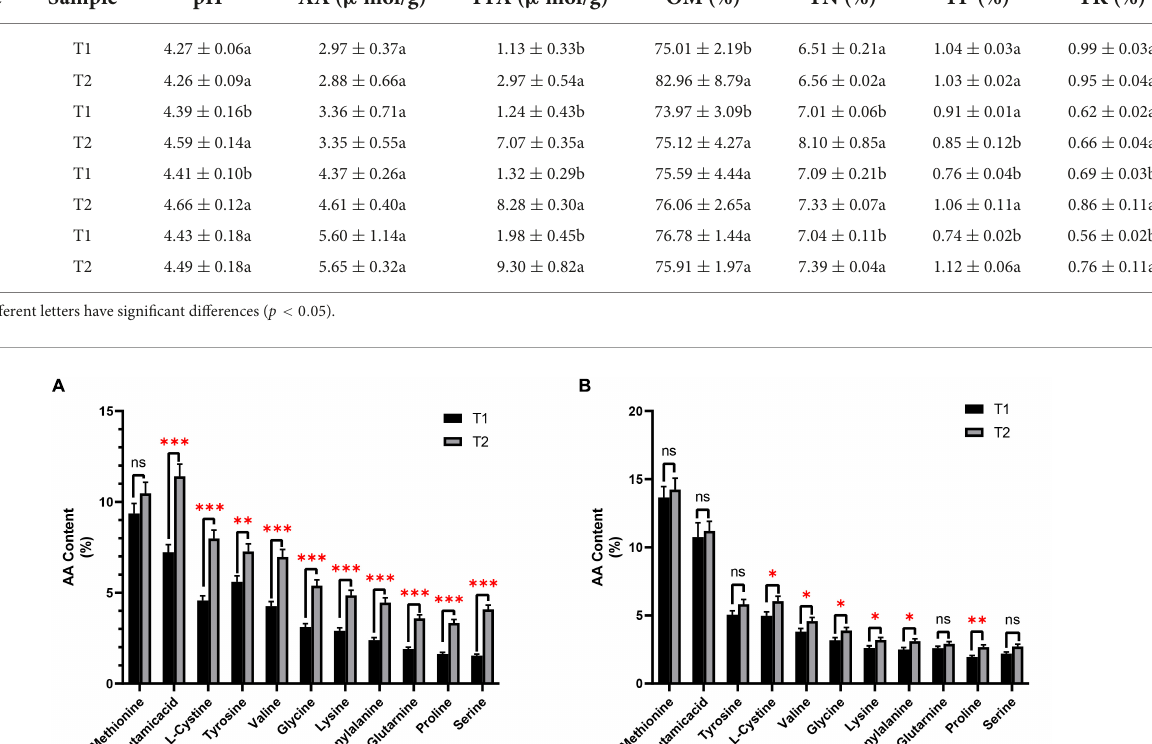
TABLE 1 Physical and chemical properties of T1 and T2 in fermented rapeseed cake in four stages. Stage